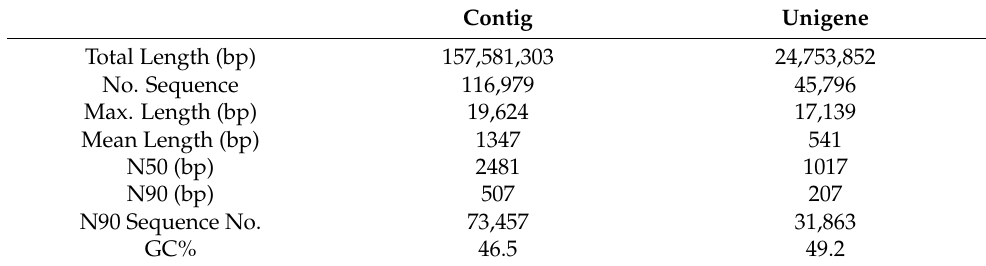
Table 2. Summary of contigs and